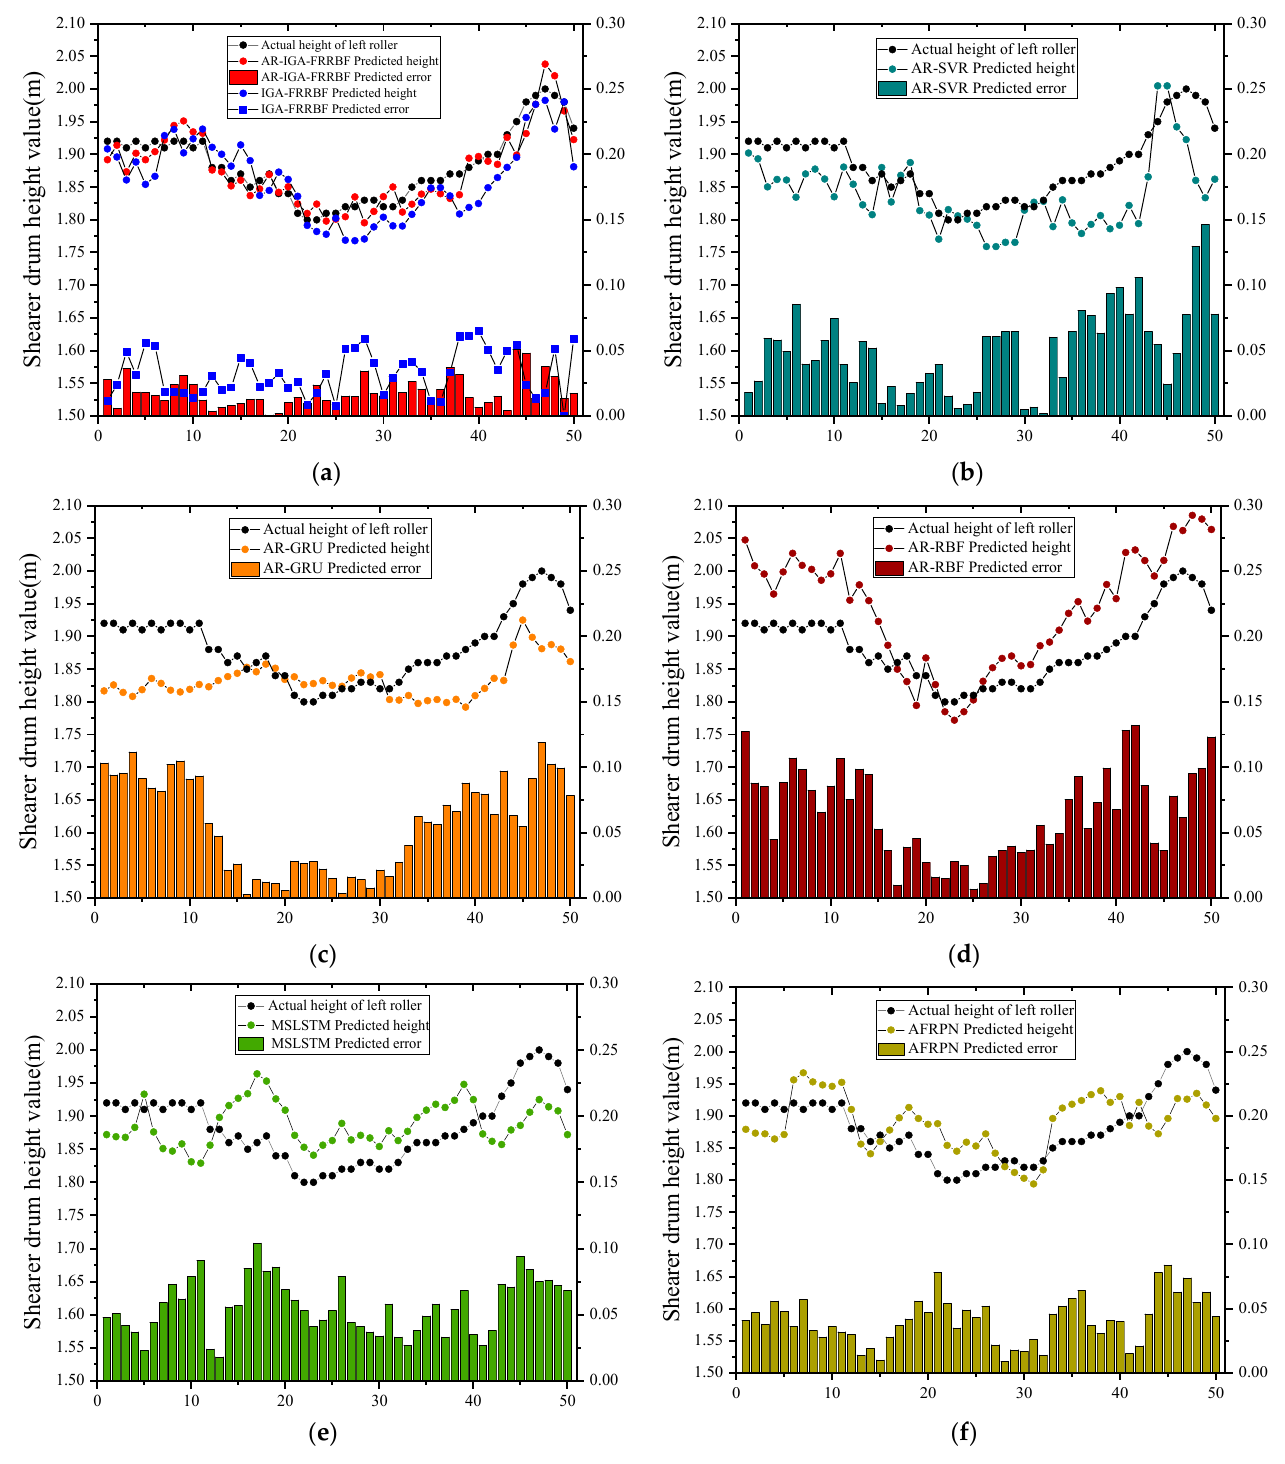
Figure 6. Comparison of height prediction of left drum of shearer with different model. ( a ) Prediction